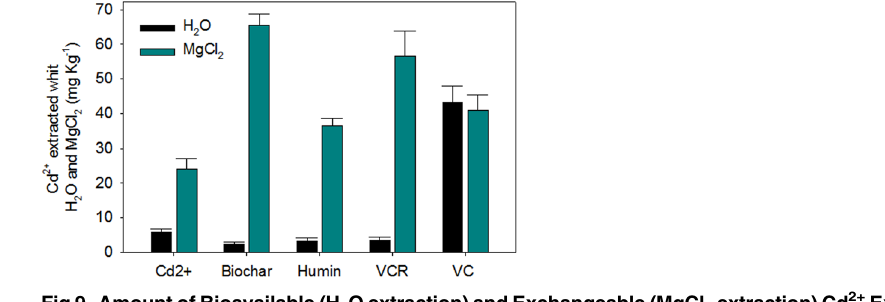
Fig 9. Amount of Bioavailable (H 2 O extraction) and Exchangeable (MgCl 2 extraction) Cd 2+ Extracted from the Substrates at the End of the Experiment (28 days after seedling transfer).